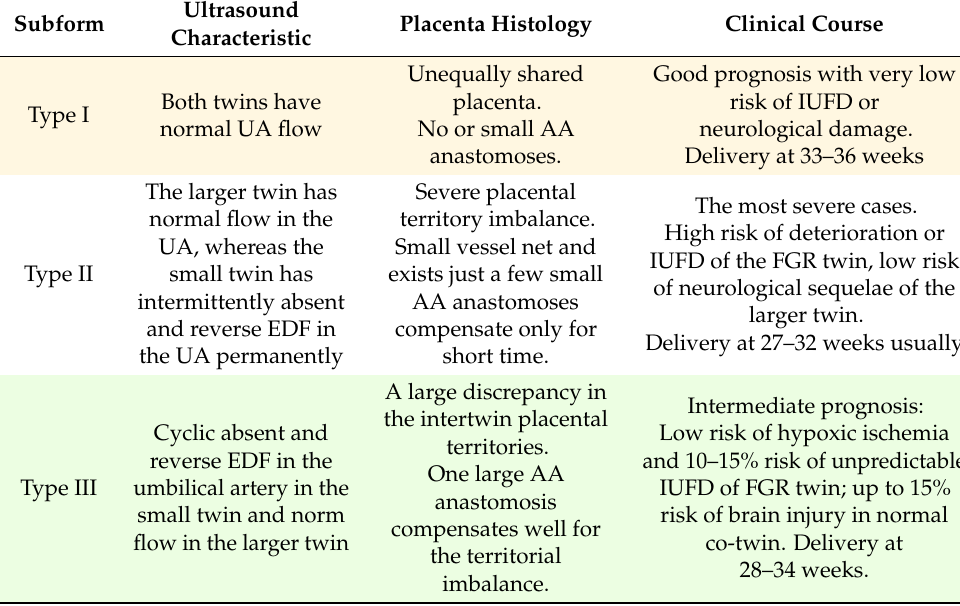
Table 1. Characteristics of the subforms of the monochorionic twins with selective fetal growth